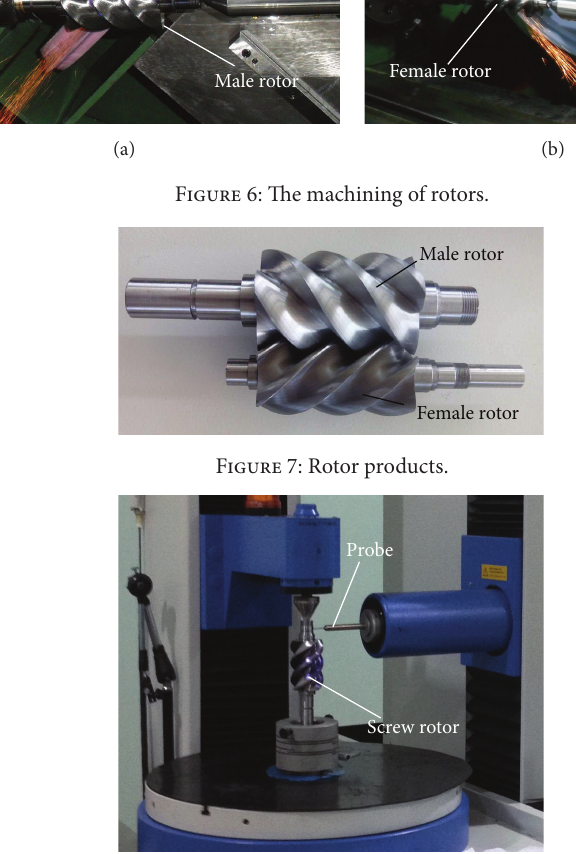
Figure 6: The machining of rotors.